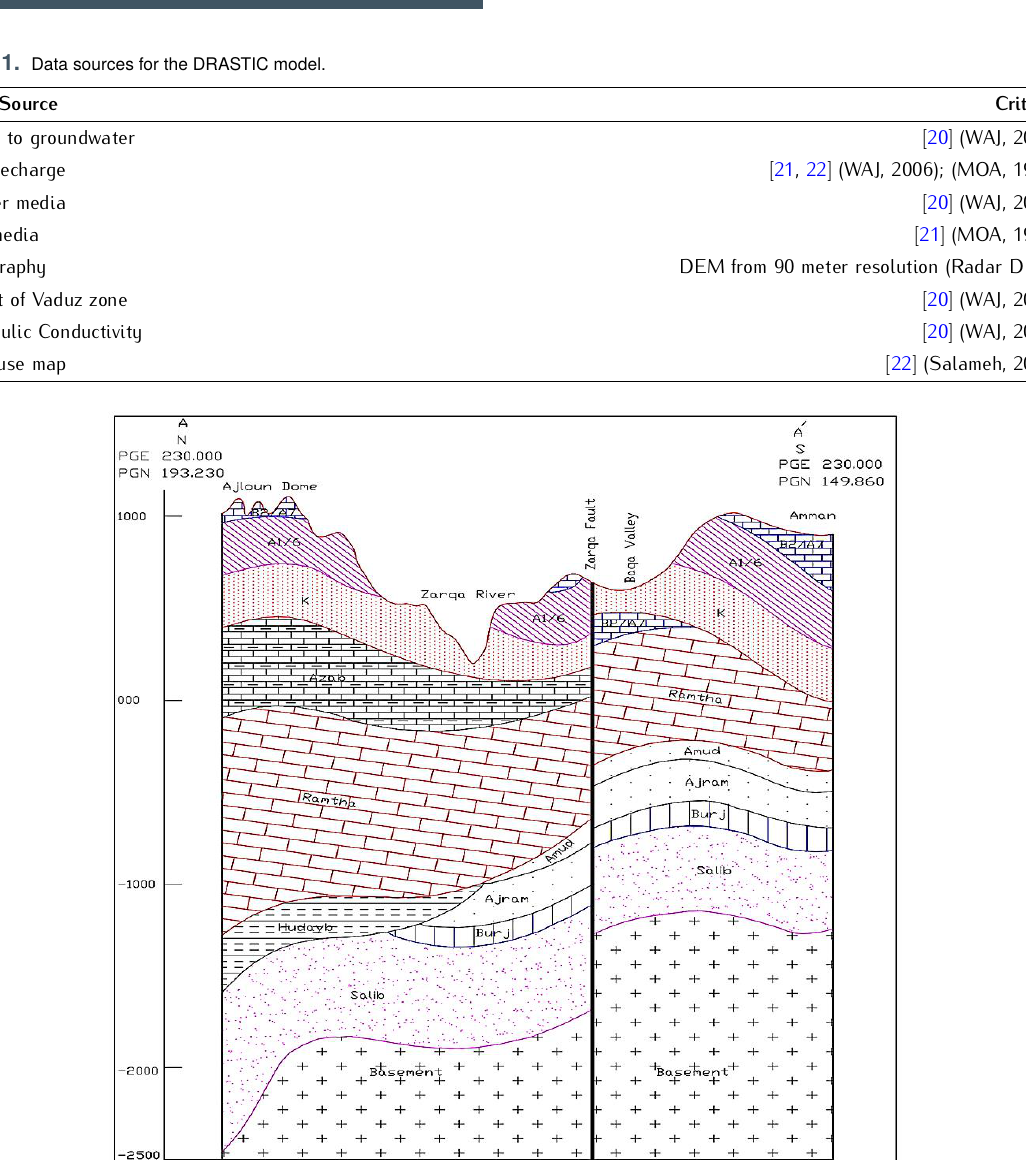
Figure 4. Geological cross-section A-A’ from Amman Zerqa Basin